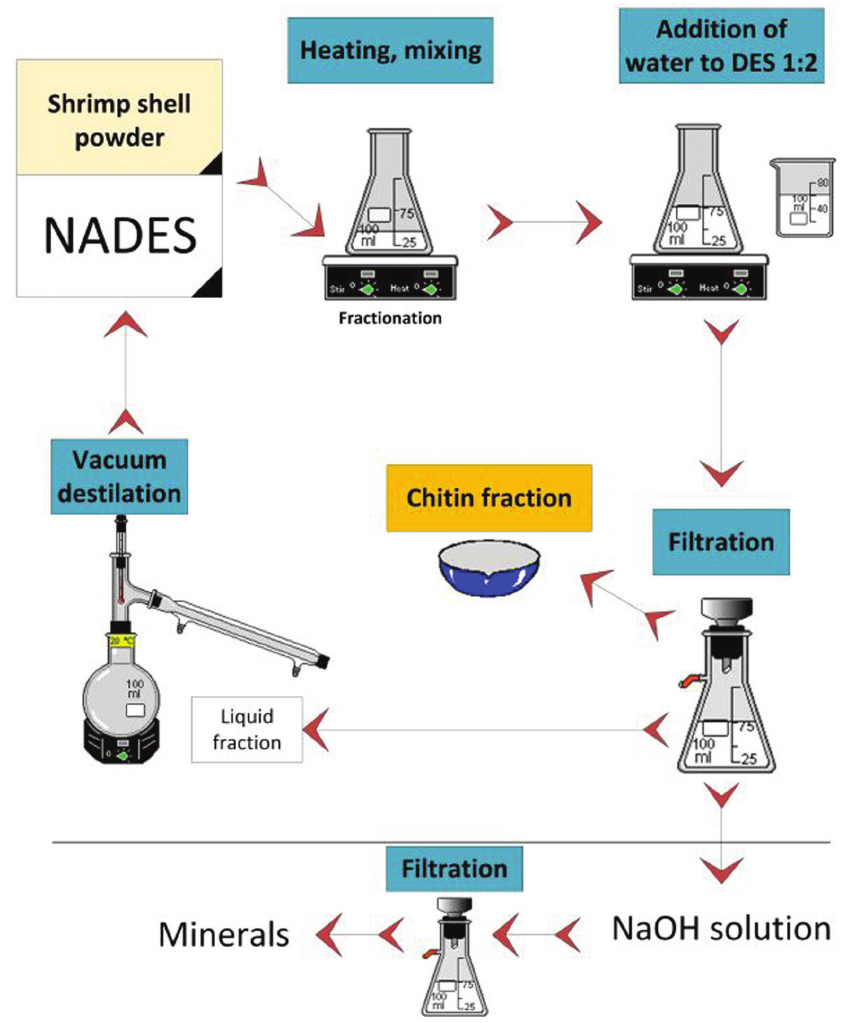
Figure 1: Sustainable process for chitin and minerals fractionation from shrimp shell by